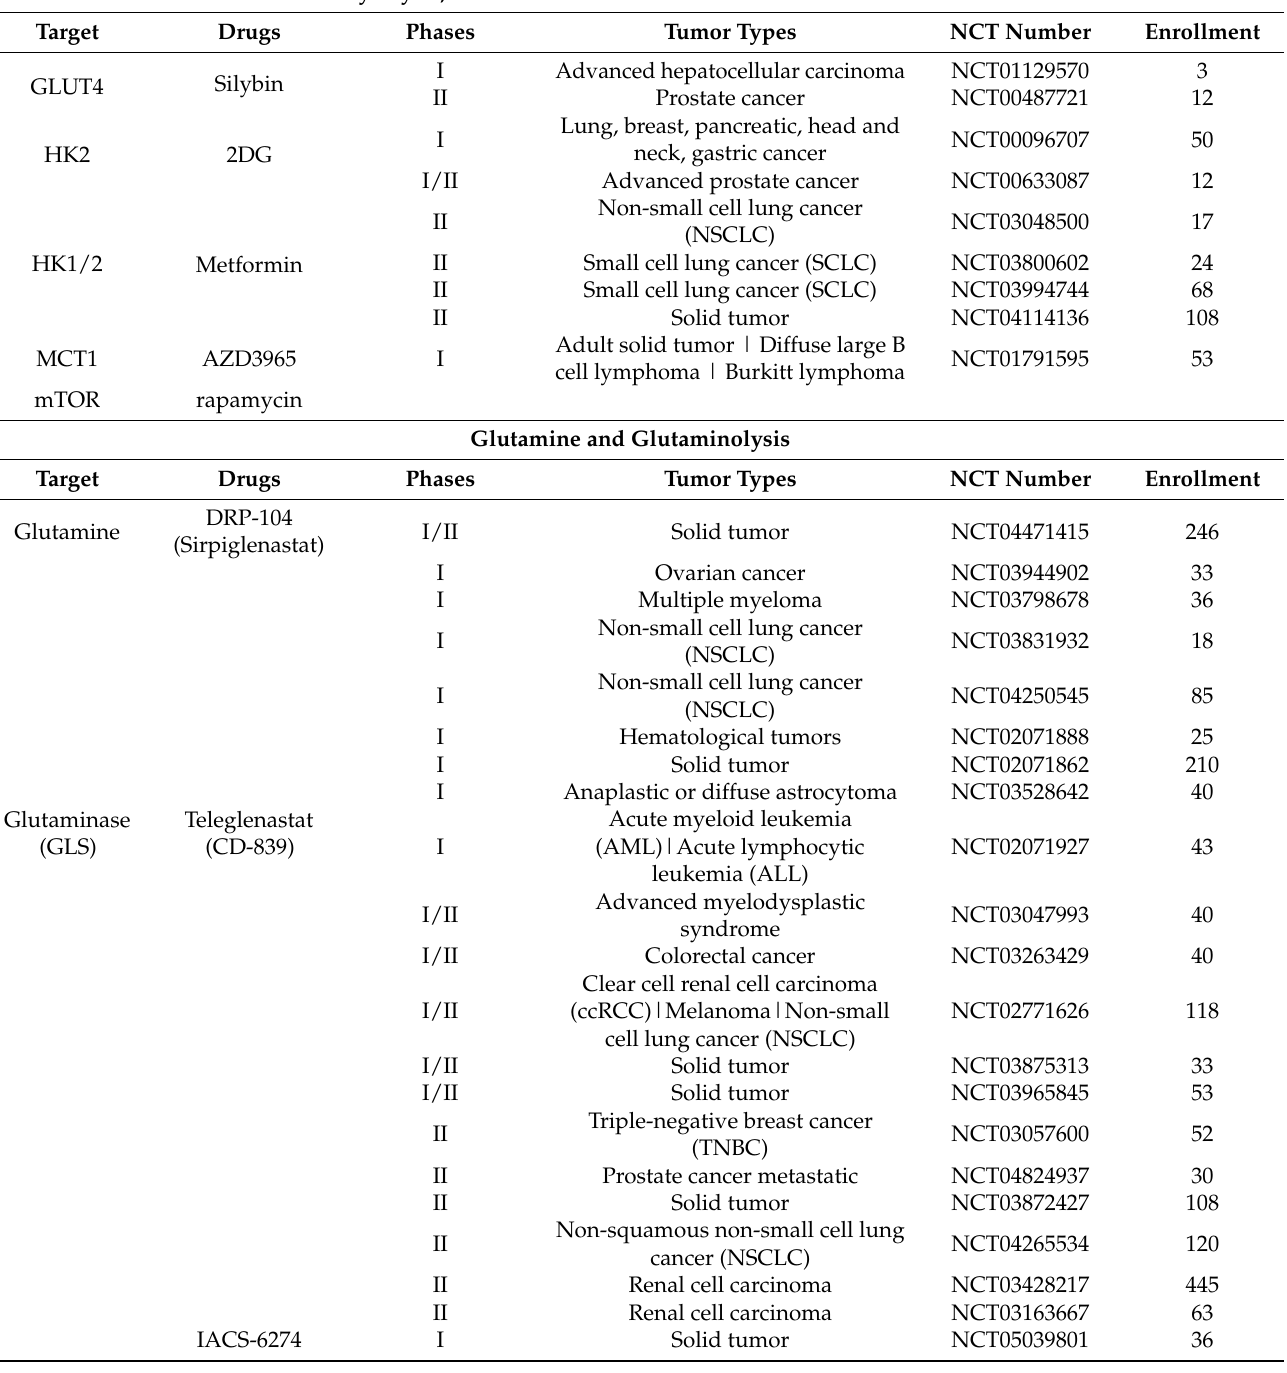
Table 1. Data of clinical trials assessing molecules that target metabolism in